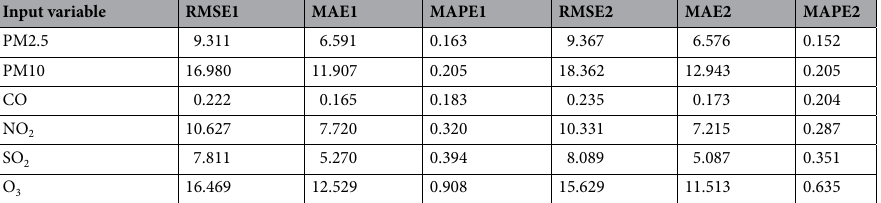
Table 4. Comparison of neural network errors between one hidden layer and two hidden layers. The first three columns are the model errors of one hidden layer of six types of pollutants, and the last three columns are the model errors of two hidden layers of six types of